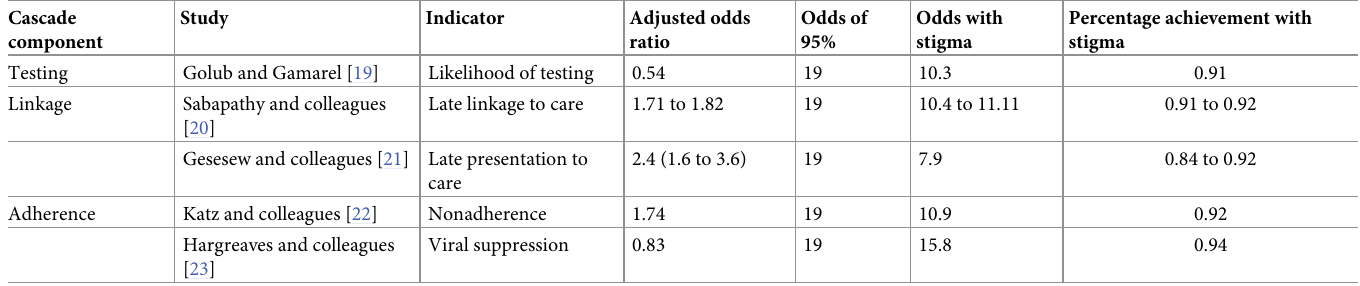
Table 5. Estimation of treatment cascade in absence of progress on